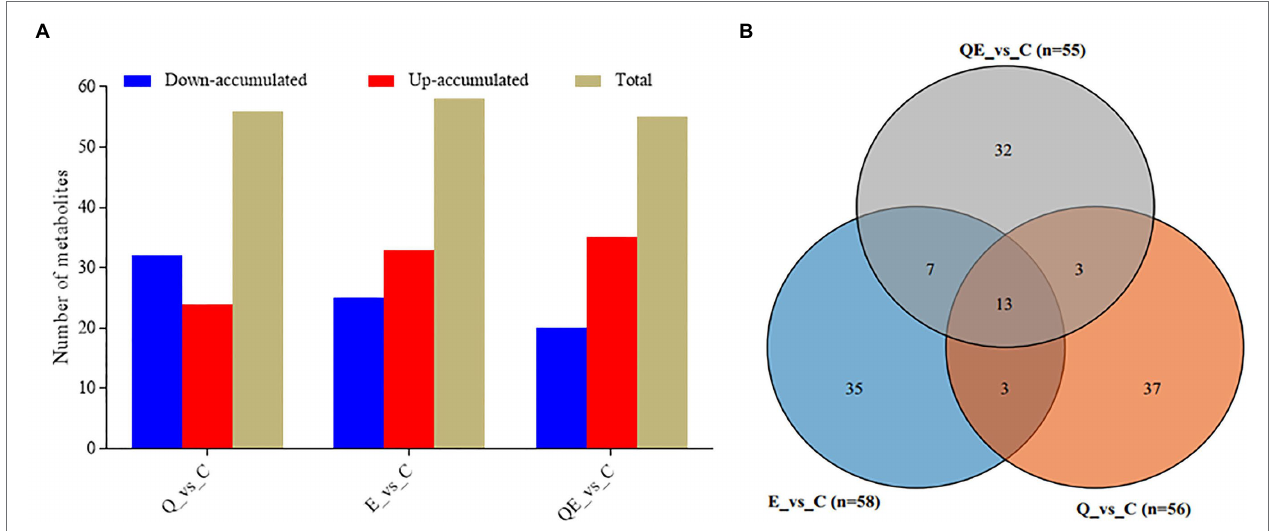
FIGURE 5 | Differentially accumulated metabolites (DAMs) detected in the cecum of the aged breeder chickens fed with dietary quercetin (Q), vitamin E (E), and QE compared with the control group (C). (A) Total number of DAMs and their accumulation levels. (B) Venn diagram of DAMs detected in the C group against either Q, E, or QE group. The partial least square discriminant analysis of log2 fold change ≥ 1 and variable importance in projection ≥ 1 were used to screen for DAMs.